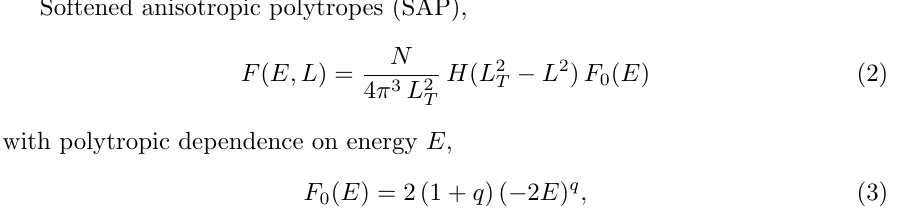
Fig. 1. Global anisotropy ξ for the generalized polytropes (left) and softened anisotropic polytropes (right). Limit ξ → 1 stands for the purely radial models. but always isotropic in the center within the so-called anisotropic radius r a